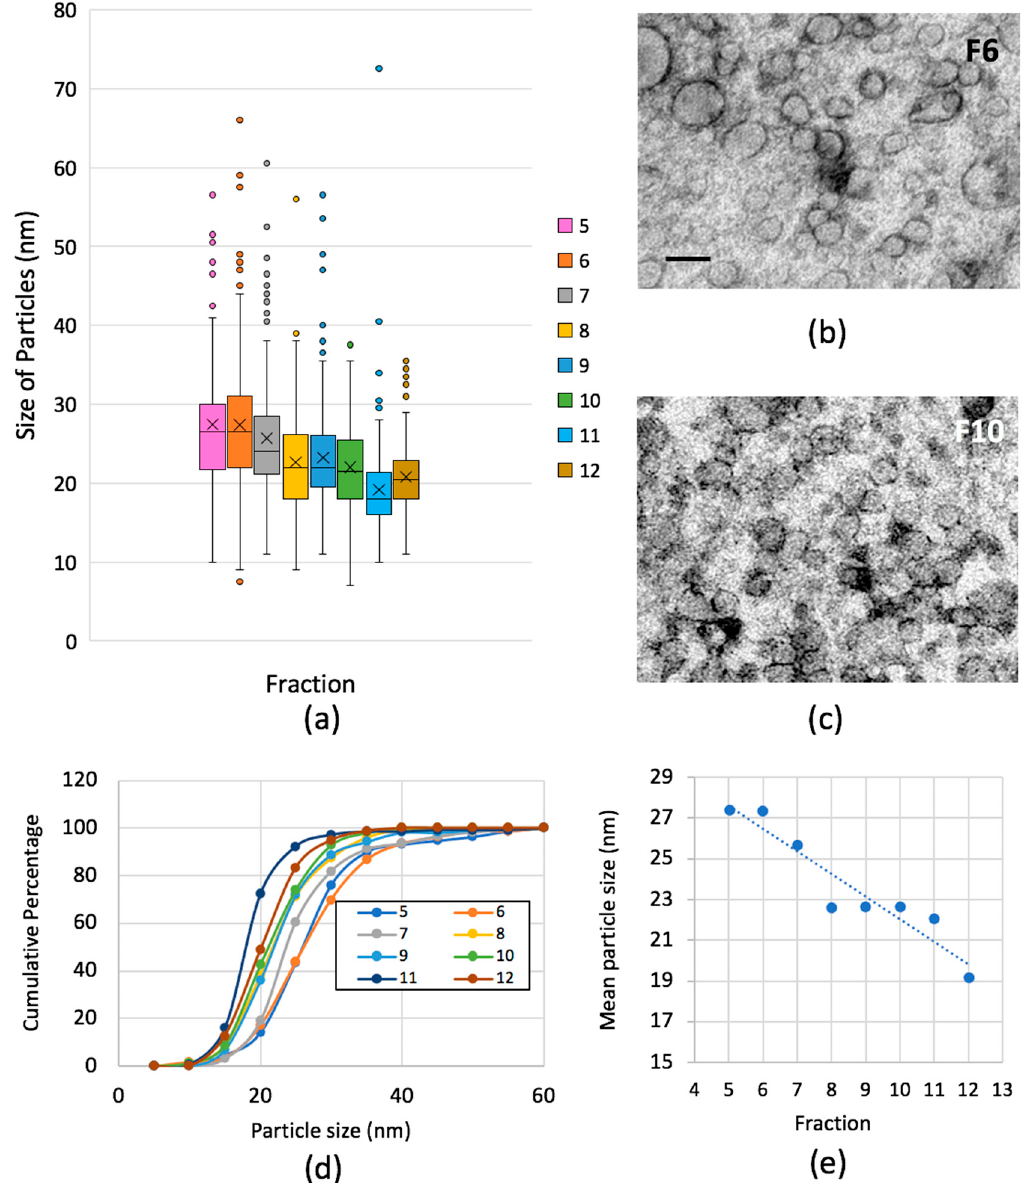
Figure 5. Lipoprotein particles in gel filtration fractions from human plasma. Fraction 4 and fraction 13 showed no detectable vesicles / LPs. ( a ) Black horizontal lines are mean size, boxes and error bars are quartiles above and below mean excluding outliers (dots); x marks median. ( b ) and ( c ) illustrate LPs found in fractions 6 (F6) and 10 (F10), respectively. ( d ) Comparison of cumulative distributions across gel filtration fractions (grouped into 5-nm size ranges); Kolmogorov-Smirnov (KS) tests as follows: F5 vs. 6 not significant; for F5 vs. 7, 8, 9, 10, 11 or 12 ps = or < 0.001. ( e ) Mean particle size decreased progressively across the fractions; y = − 1.1122x + 33.162, R² = 0.8992. Scale bar 50 nm for images in both ( b ) and ( c ).